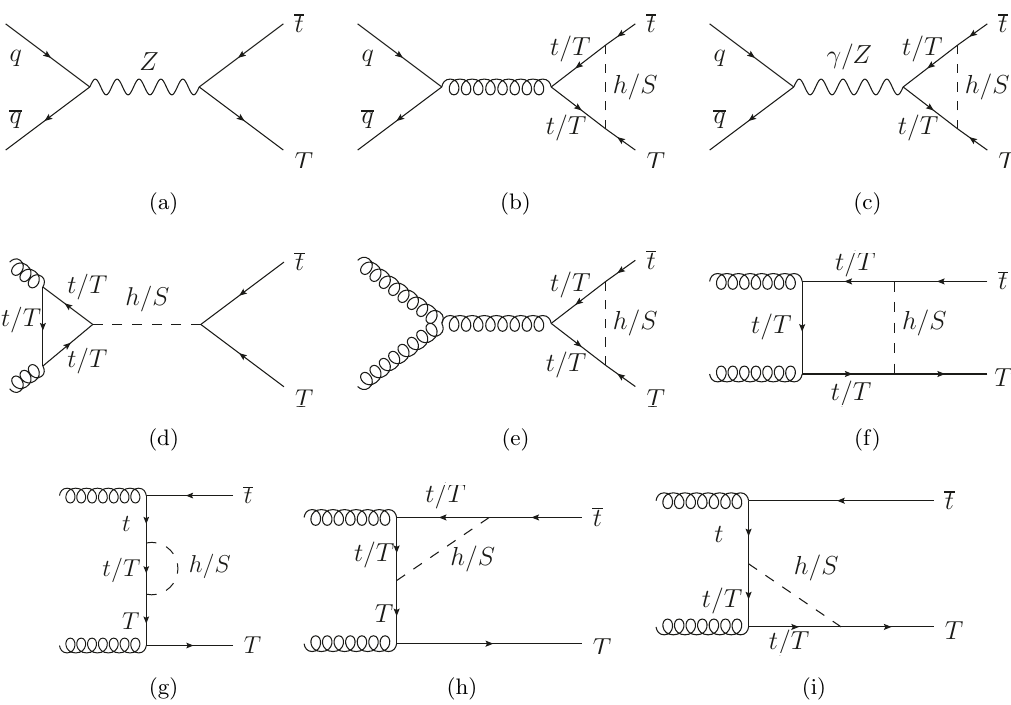
Figure 4 . Representative Feynman diagrams for single production of T in association with a top quark for (a) tree level through an s -channel Z , (b-c) quark-antiquark initial state, and (d-i) gluon fusion. We have not shown the conjugate process, counterterms, o(cid:11)-diagonal self energies of the external top and top partner, or any loops with internal Goldstone bosons, Z , or W (cid:6) .